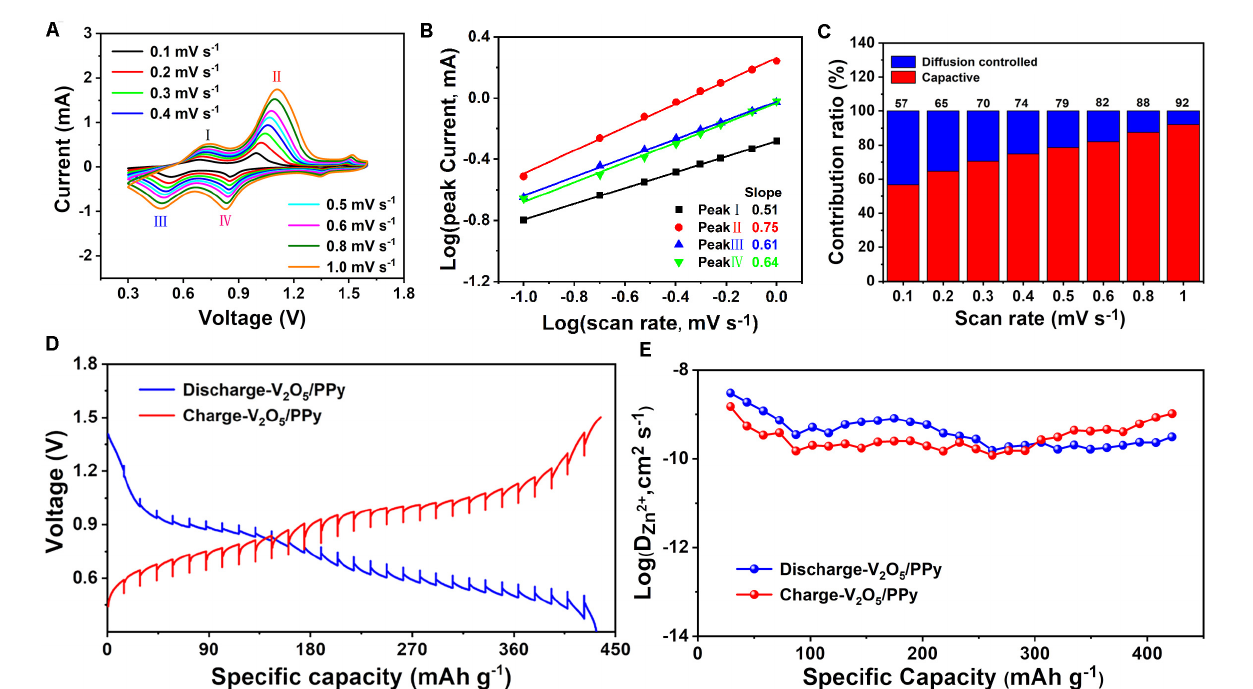
FIGURE 3 | The electrochemical kinetics of the V 2 O 5 /PPy composite cathode. (A) CV curves at different scan rates. (B) Log(peak current) vs. log(scan rate) plots for different peaks marked in (A) . (C) Capacity contribution ratios at different scan rates. (D) GITT curves. (E) Evaluated diffusion coefficients of Zn 2 + .